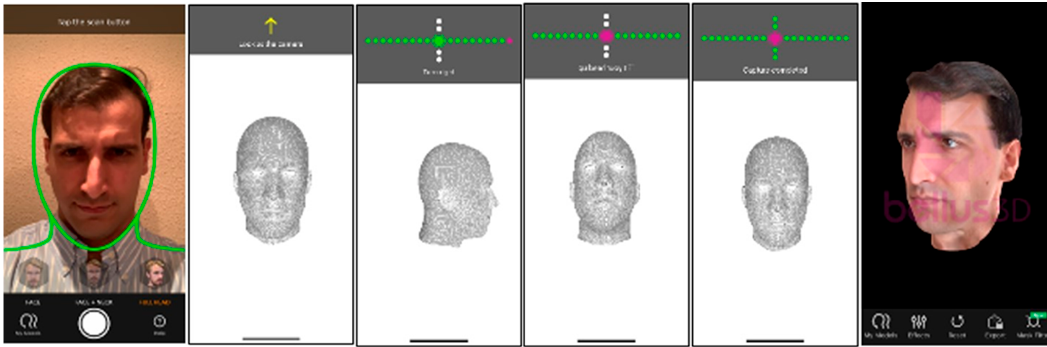
Figure 1. Face scan acquisition procedure. Of the three available scanning options (face, face + neck, full head) the second one is recommended by the authors of the present paper for the Mask Fitter purposes. Option one (face only) takes an insufficiently detailed scan of the chin area, while option three (full head) is redundant as the back of the head is not involved in the Mask Fitter design. At the end of an approximately 30 s scan process, followed by another approximately 20 s for data computing, the 3D-representation of the face is generated. After selection of the function “mask fitting” and subsequently the selection of the desired design (“standard” for surgical masks, “tall” for FFP2), a Mask Fitter consisting of an anatomic frame is automatically designed by the software with a 10 s processing time (Figure 2a). Figure 2. ( a , b ): The Mask Fitter design generated by the software. The generated Mask Fitter design can then be exported as a .stl file (Figure 2b). The free version of the software does not allow the face-scanning to be saved, but it does allow the sending of the .stl file of the generated design of the Mask Fitter via email. Once the file is received by email it can be 3D-printed. Partner services are suggested from the Company itself, but any 3D-printing services, available online at different, but reasonable prices (e.g., GBP 10–15 UK currency), can be used. Alternatively, and more conveniently, the Mask Fitter can be printed by any Office, Department, University, Company, Dental Laboratory or even personal 3D-printer (Figures 3–5) as there are no special requirements for the printer and the material. A basic Stereolithography (SLA—Resin) 3D-printer or a basic Fused Deposition Modeling (FDM—filament) 3D-printer can efficiently 3D-print the Mask Fitter.